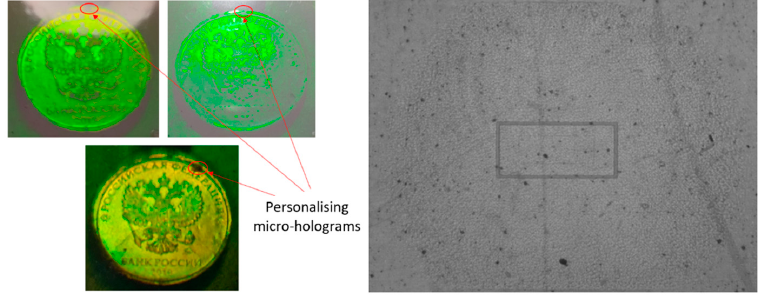
Figure 12. Examples of optical security element with micro-CGH.